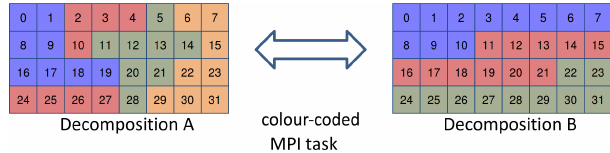
Figure 5. The YAXT library facilitates MPI communication be- tween concurrent components with different domain decomposition